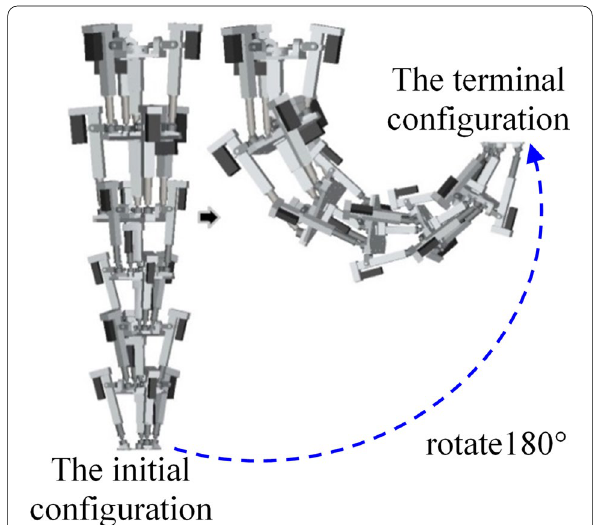
Figure 7 Virtual